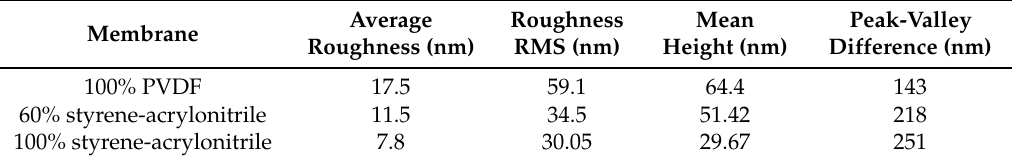
Table 5. Surface characteristics of styrene-acrylonitrile-modified PVDF